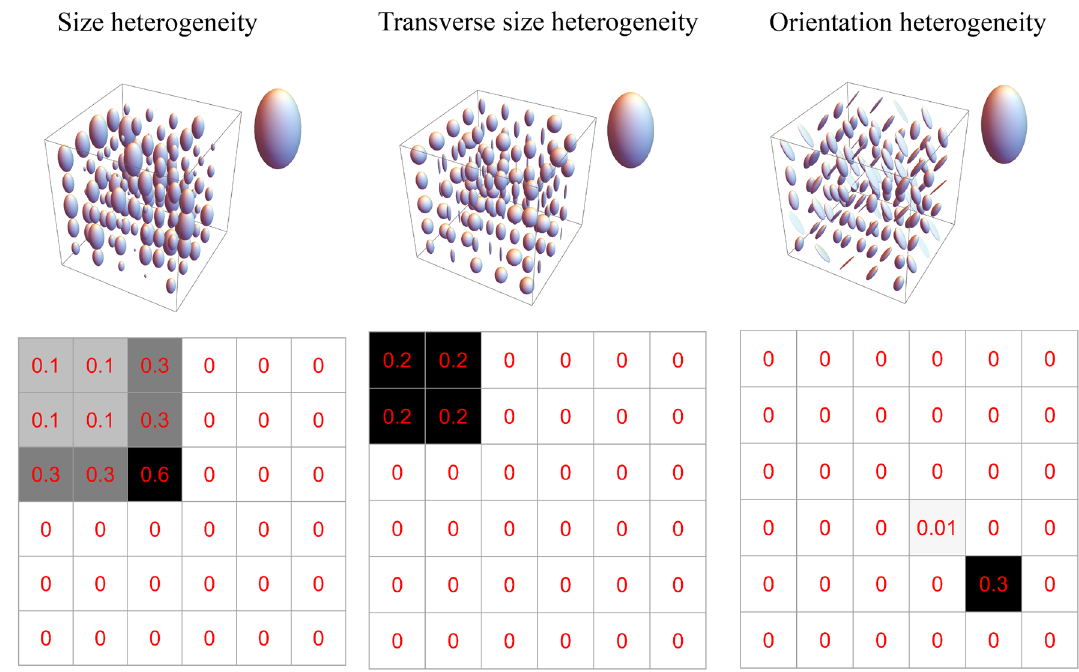
Figure 3. Macroscopically anisotropic and microscopically heterogeneous DTDs generated from CNTVD describing the white matter. The DTD along with the mean diffusion tensor ellipsoid (inset) is shown in the 6 covariance matrix with non-zero elements highlighted is shown in the top row while the structure of the 6 × bottom row. (Left column) Emulsion type DTD with size heterogeneity, (Middle column) DTD with random transverse eigenvalues characterizing a bundle of white matter fibers of varying diameters, (Right column) Crossing fiber DTD with 90-degree angle between the fibers. The above graphics was generated using the Mathematica software 67 .